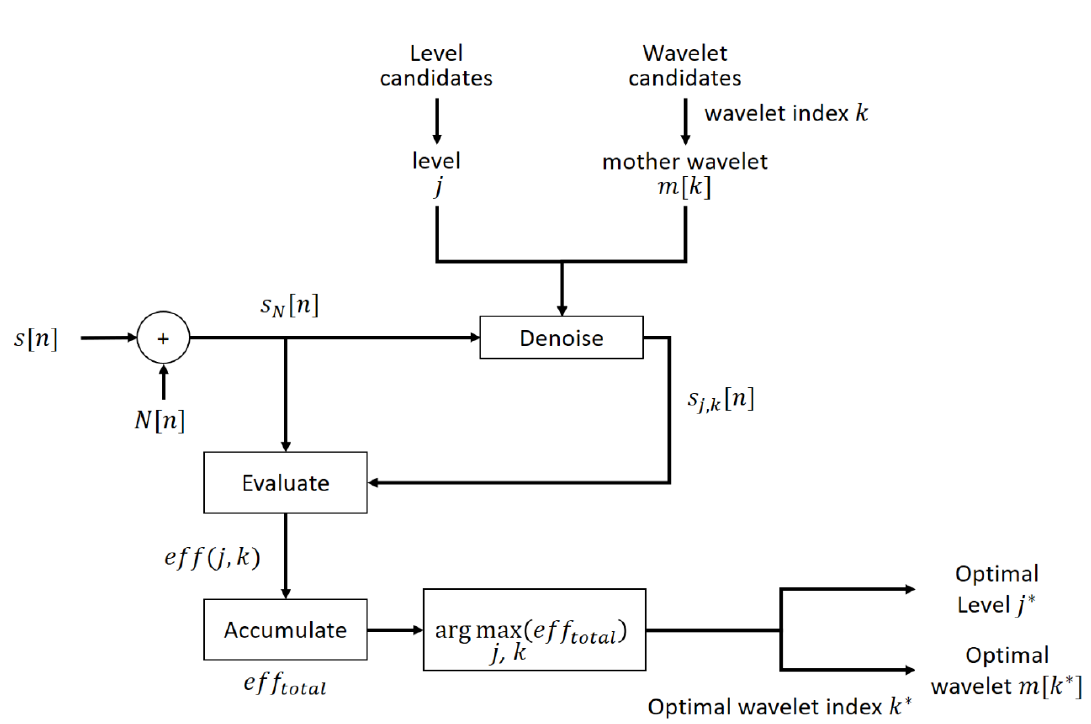
Figure 5. The block diagram of the optimal selection process for the mother wavelet function m [ k ∗ ] and decomposition level j ∗ .